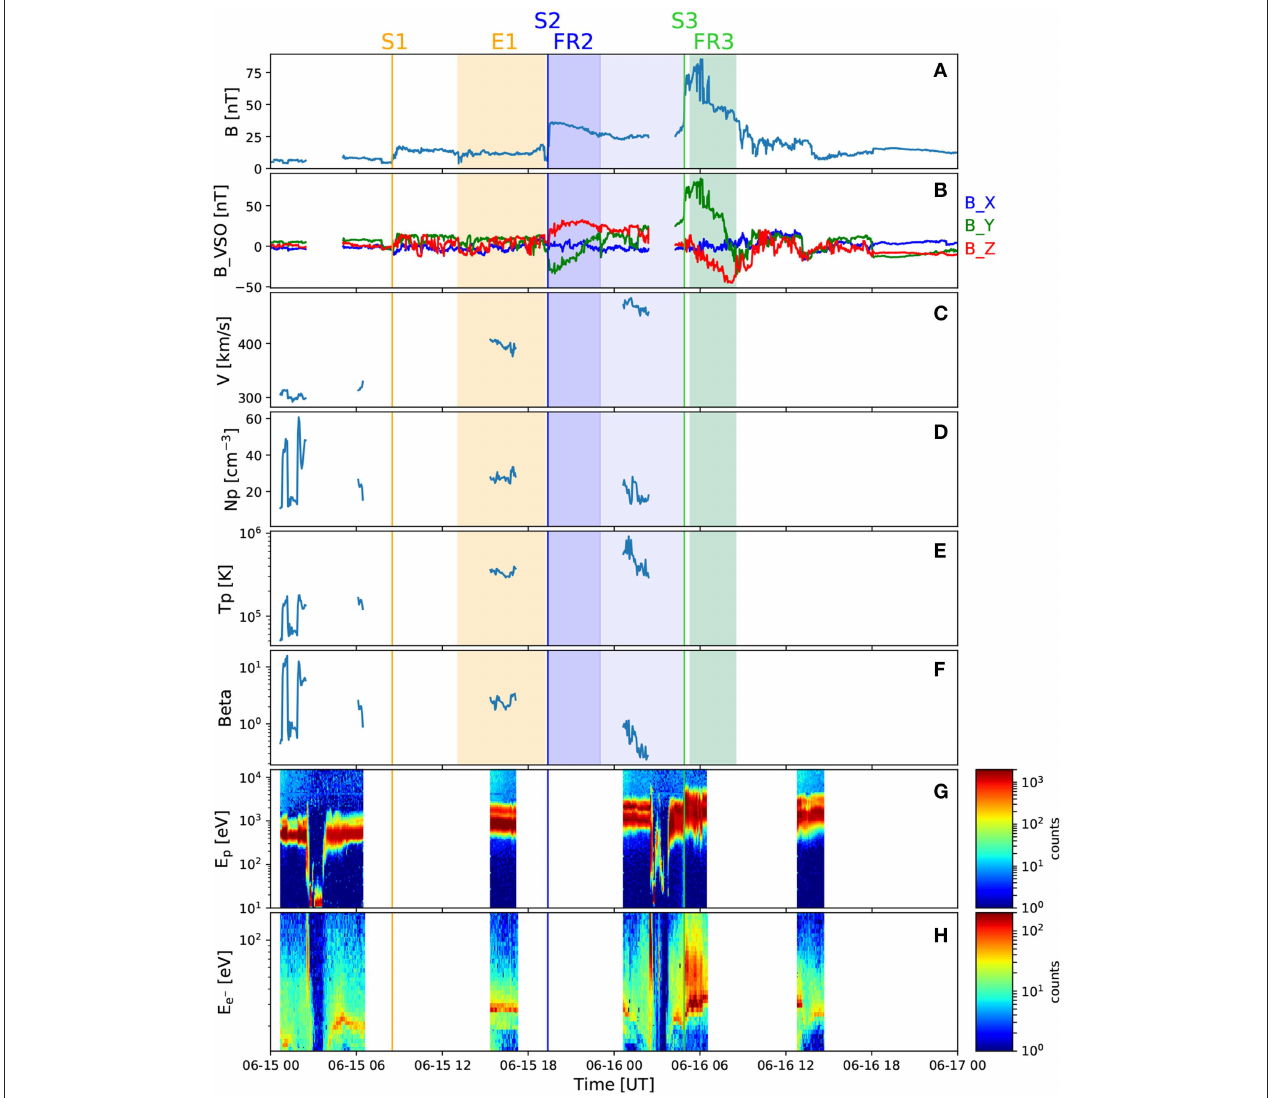
FIGURE 4 | In-situ measurements taken by VEX around Venus. The panels show, from top to bottom: (A) magnetic field magnitude, (B) magnetic field components in VSO coordinates (blue: B x , green: B y , red: B z ), solar wind (C) speed, (D) density, (E) temperature, and (F) plasma beta, and counts for (G) protons and (H) electrons. The CME-driven shocks (S1, S2, and S3) are marked by vertical lines, while the ejecta and flux ropes (E1, FR2, and FR3) are highlighted with shaded regions. Intervals in the Venusian magnetosphere have been cut out from the magnetic field and plasma data. ASPERA-4, providing electron and proton counts (and from which plasma data are derived), was operational at periapsis and apoapsis